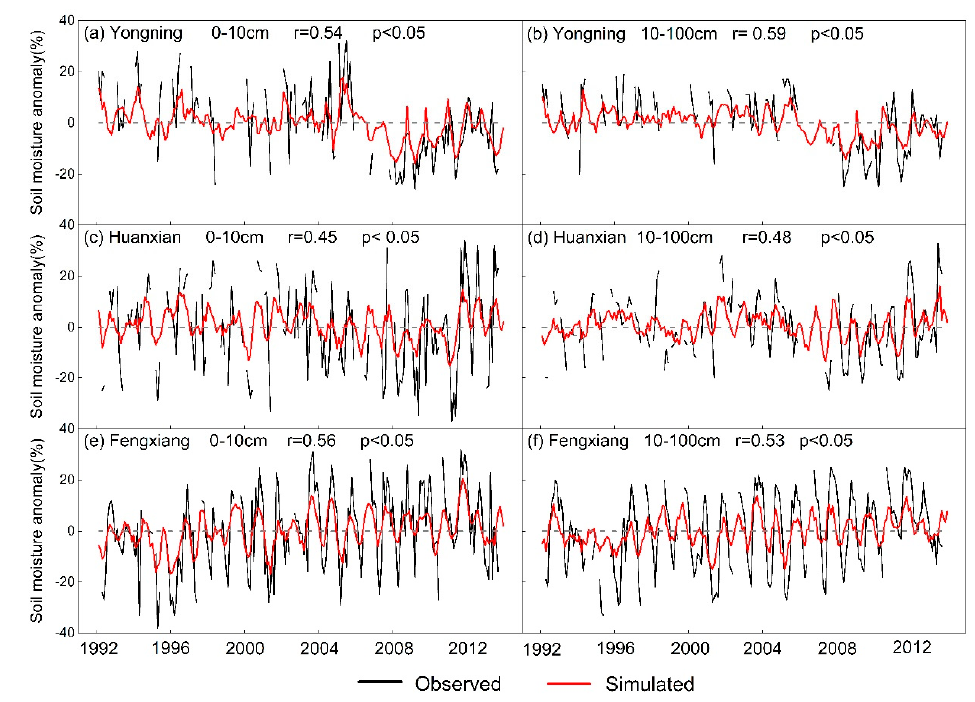
Figure 4. Comparison between simulated and observed soil moisture anomalies for depths of 0–10 cm and 10–100 cm in three typical stations.